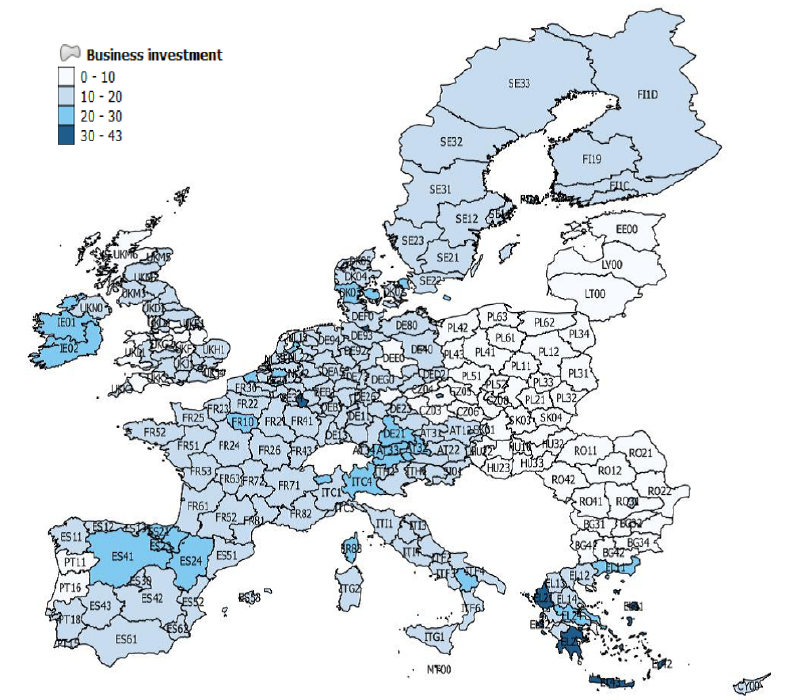
Figure 2: Business investment per employee (thousand EUR/employee) –